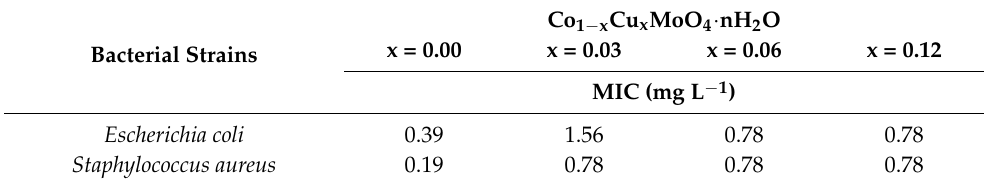
Table 5. Minimum Inhibitory Concentration (MIC) for Co 1 − x Cu x MoO 4 · nH 2 O materials with x equals to 0.00, 0.03, 0.06 and 0.12 against Escherichia coli and Staphylococcus aureus